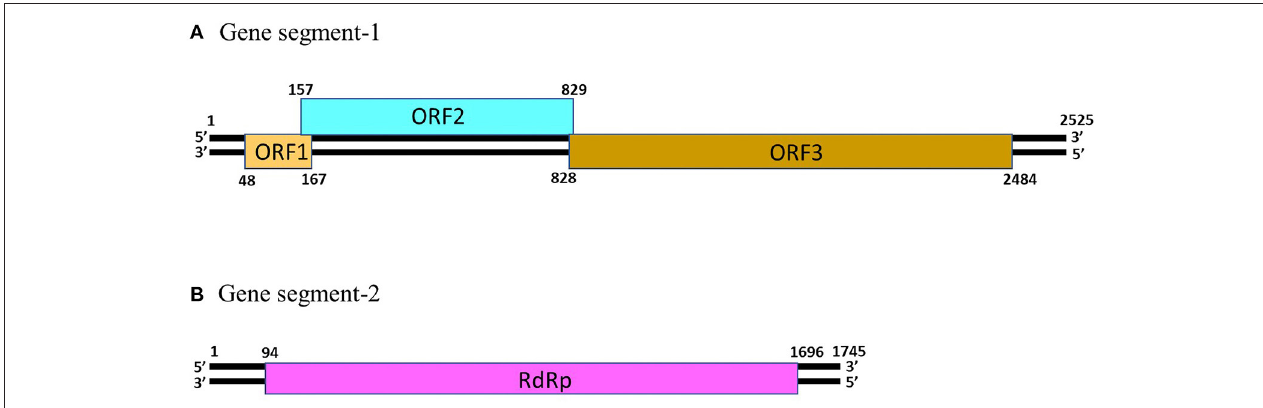
FIGURE 1 | The genomic organization of human picobirnavirus genogroup-I strain Hy005102. (A) Gene segment-1 (GenBank accession number AB186897) of PBV strain Hy005102 consists of 3 putative open reading frames (ORF), designated as ORF1, ORF2 and ORF3. The ORF3 codes for a precursor of the viral capsid protein. (B) Gene segment-2 (GenBank accession number AB186898) of PBV strain Hy005102 possess a single ORF that encodes the viral RNA-dependent RNA polymerase